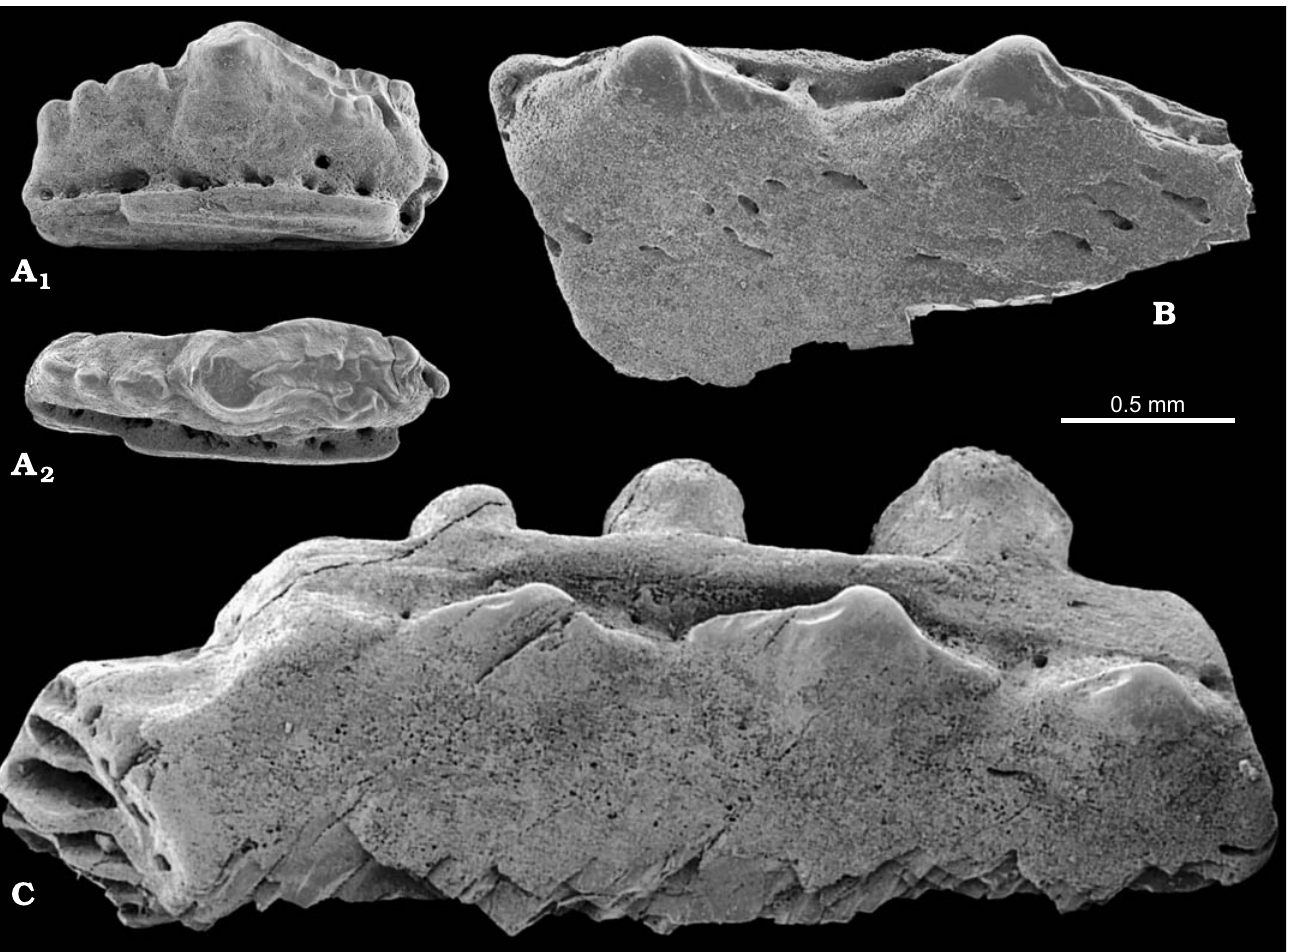
Fig. 13. SEM micrographs of ischnacanthiform jaw bone fragments from early Frasnian, horizon GI4 of an unnamed formation in the Chahriseh section, Kaftari Mt., central Iran. A . First type of fragment. AEU 321 in mesial (A 1 ) and occlusal (A 2 ) views. B , C . The second type of fragment in occluso−lateral view. B . AEU 322. C . AEU